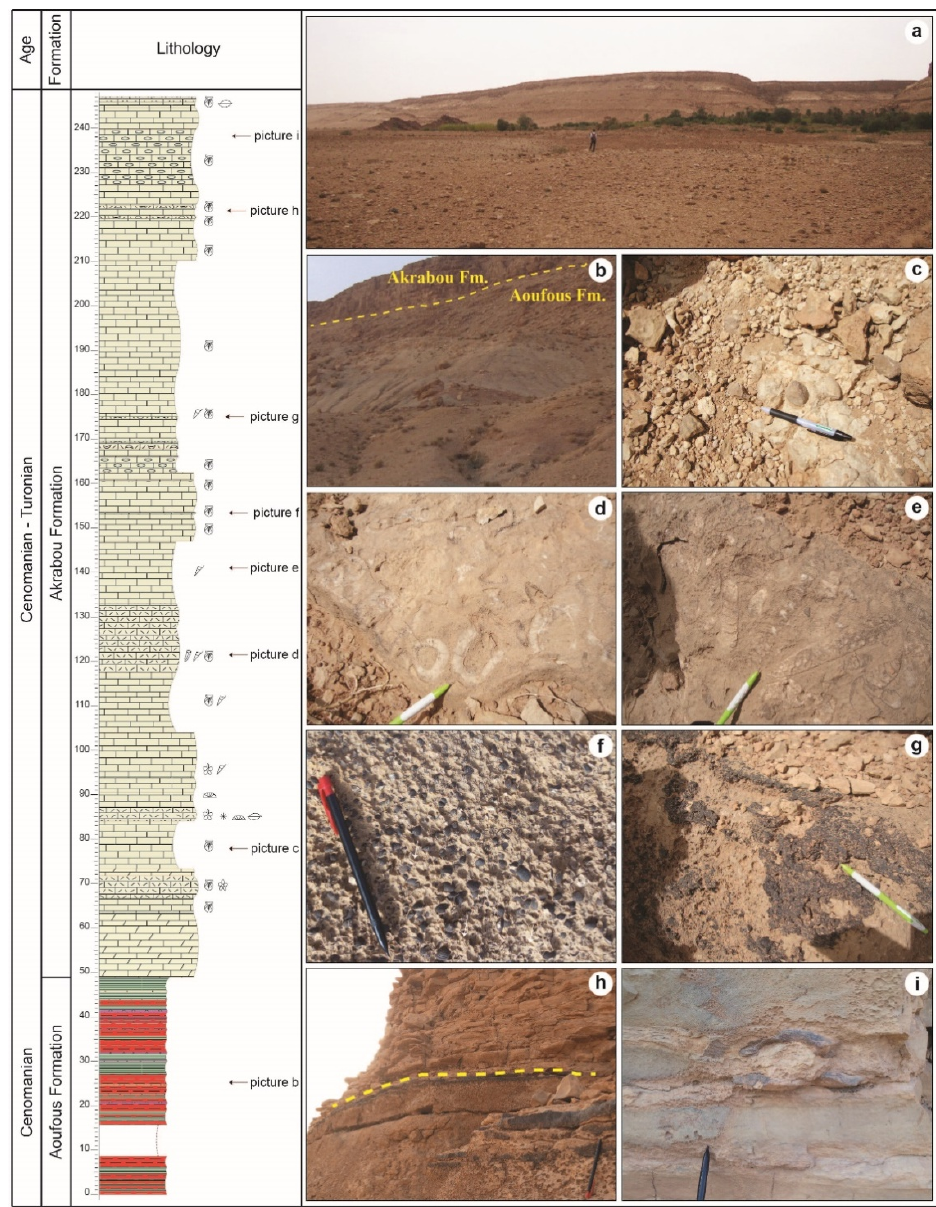
Figure 3. Tazzouguerte section. ( a ) general view, along an east–west direction, showing the logged section; ( b ) variegated facies of the Aoufous Formation and the limestones of the Akrabou Formation; ( c ) fine limestone with bivalve shells; ( d ) limestone with rudists; ( e ) gastropod bioclastic limestone; ( f ) surface with bivalve shells; ( g ) limestone with silicified shell assemblages; ( h ) bedded limestone lying on a lumachelic level; ( i ) fine limestone with chert nodules.